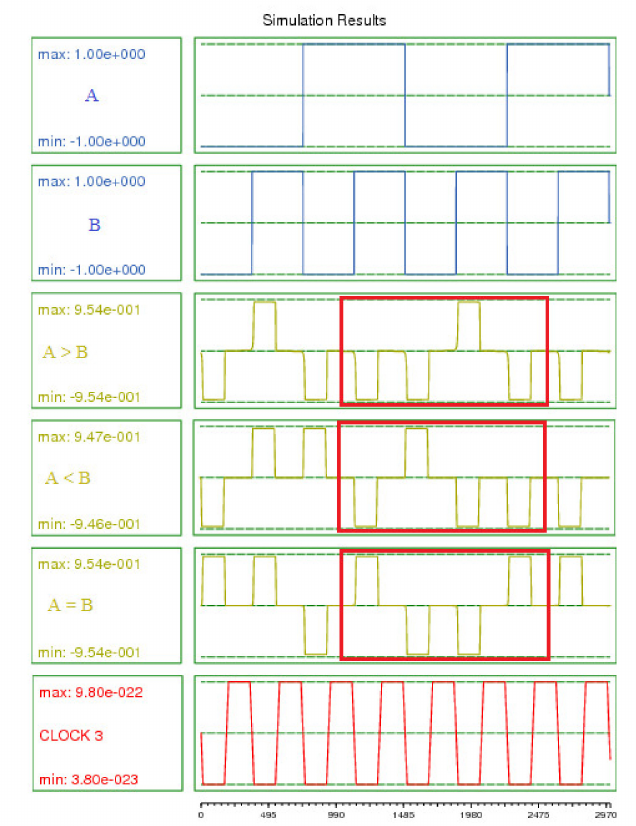
Figure 14. Simulation results for the proposed 1-bit comparator.